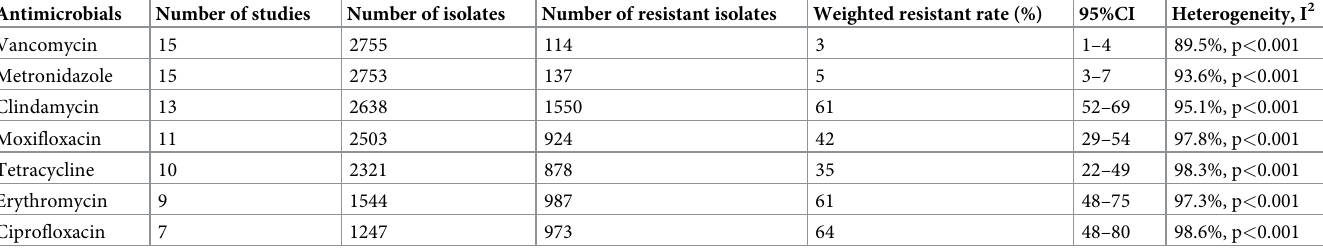
Fig 5. Forest plots for the proportion of C . difficile by year of publication among hospitalized diarrheal patients. https://doi.org/10.1371/journal.pone.0262597.g005 Metronidazole and vancomycin are two main first-line antibiotics that are used to treat pri- mary and recurrent CDI [57]. In this review, metronidazole and vancomycin were still the drugs of choice as indicated by less pooled resistances, 5% and 3%, respectively (Table 3). The pooled resistances of C . difficile against metronidazole and vancomycin were 5% and 3%, Table 3. The Weighted Pooled Resistant (WPR) rate of C . difficile for each antimicrobial from hospitalized diarrheal patients.